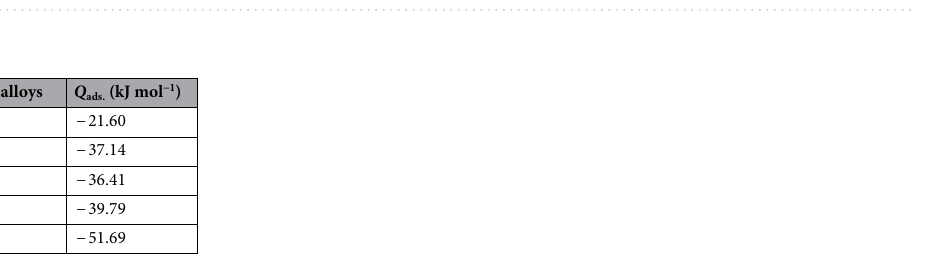
Table 5. The heat of adsorption ( Q ads. ) for Al and Al–Ti alloys in the presence of 1 mM of MBT inhibitor.